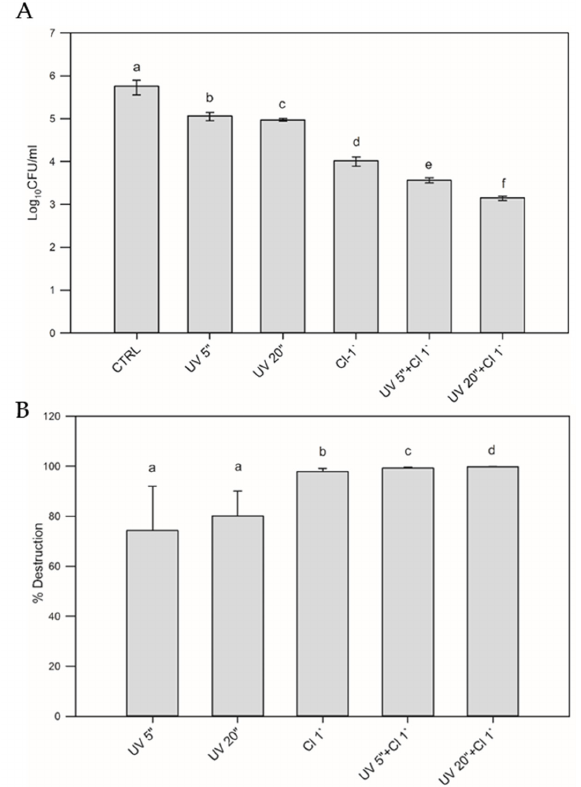
Figure 3. Destruction of a 5-day-old biofilm (log 10 CFU/mL) ( A ) after treatment with UV 5 (UV 5”) and 20 s (UV 20”), 0.4 mg/L of Cl for 1 min (Cl 1’), combination of UV 5 s and Cl for 1 min (UV 5” + Cl 1’), and UV for 20 s and Cl for 1 min. The control is represented by an untreated biofilm. The mean values are shown along with the standard deviations. ( B ) % of destruction of a mature biofilm after the above treatments. Lowercase letters above the results indicate the statistical significance. The same letters indicate that there is no statistically significant difference between groups while different letters indicate a statistically significant difference tested by Students t -test for UV 20” + Cl 1’ vs. UV 5” + Cl 1’ and UV 5” + Cl 1’ vs. Cl 1’ and Mann–Whitney U test for other samples. The results show that the applied treatments significantly reduced the number of bacteria in the biofilm compared to the untreated biofilm as follows: UV for 5 and 20 s ( p = 0.0012), 1 min Cl ( p = 0.0001), UV 5 s and 1 min Cl ( p = 0.00018), UV for 20 s and 1 min Cl ( p < 0.0001). A significant difference was also found between the effect of individual treat- ments, from the least effective UV to the most effective treatment, which was achieved by combining UV for 20 s with 1 min Cl. The destruction of a mature biofilm with different treatments shows results ranging from 66.67% to 99.99%. The effects of UV 5 s with reduc- tion of 74.34% and UV 20 s with reduction of 80.19% are less successful in mature biofilm destruction then Cl alone or combined with UV. Cl 1 min treatment achieved biofilm re- duction of 97.82%. With UV 5 s and UV 20 s combined with Cl for 1 min treatment, over 99% reduction was observed.